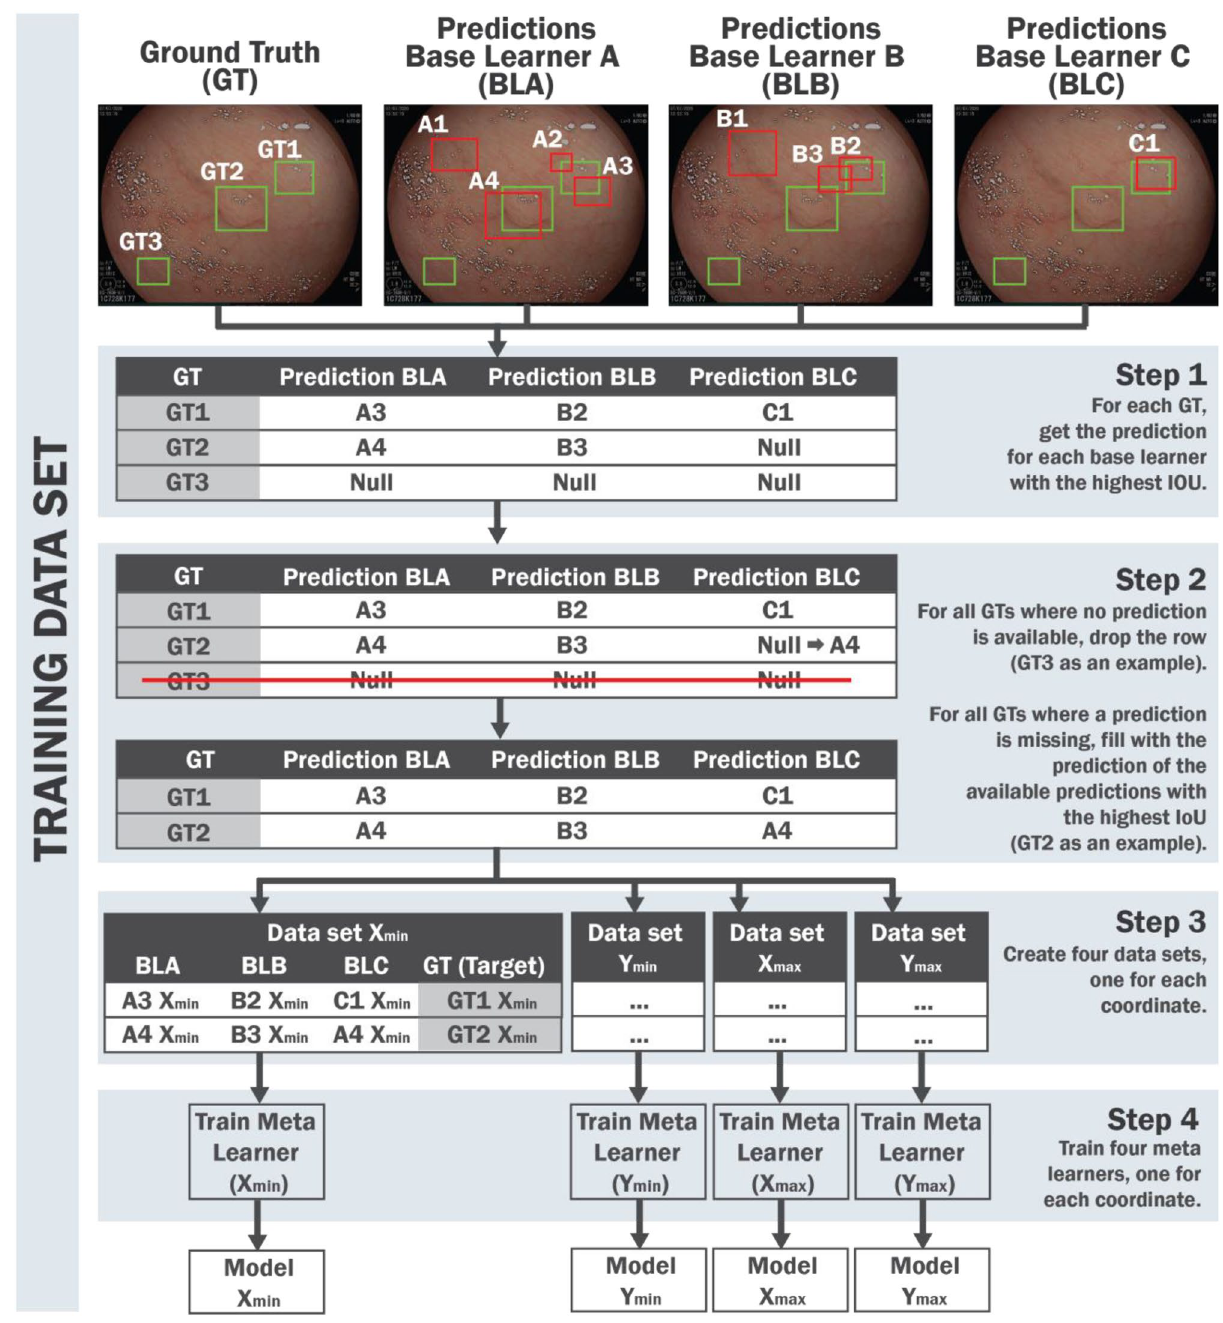
Figure 2. StackBox over the training data. In Step 1, for each ground-truth, we find the prediction of each base learner with the highest IoU. In Step 2, the ground truths without associated predictions are removed; when the number of predictions is lower than the number of base learner models used, the null values are filled with the prediction where the IoU with the ground-truth is higher. In Step 3, four data sets are created according to the coordinates available for each bounding box. The predictors include the corresponding coordinate of each base learner, and the target is the analogous coordinate of the ground truth. In Step 4, a meta-learner is applied to each data set, and the final models are saved for subsequently application to test data. The ground truth is represented by the green bounding boxes and the predictions by the red bounding